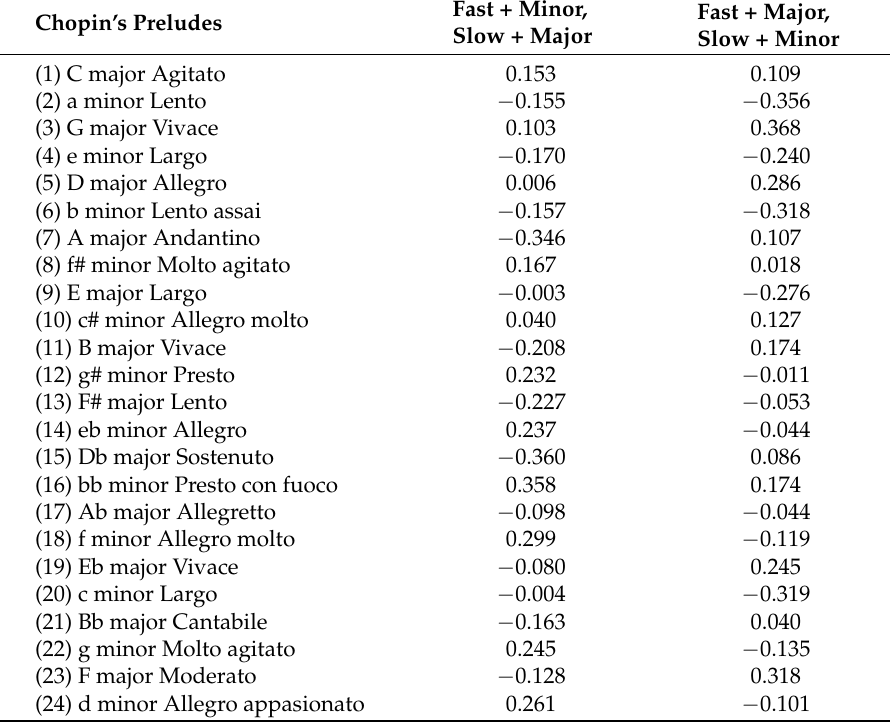
Table 20. Loading matrix A obtained by rotations for Chopin’s preludes